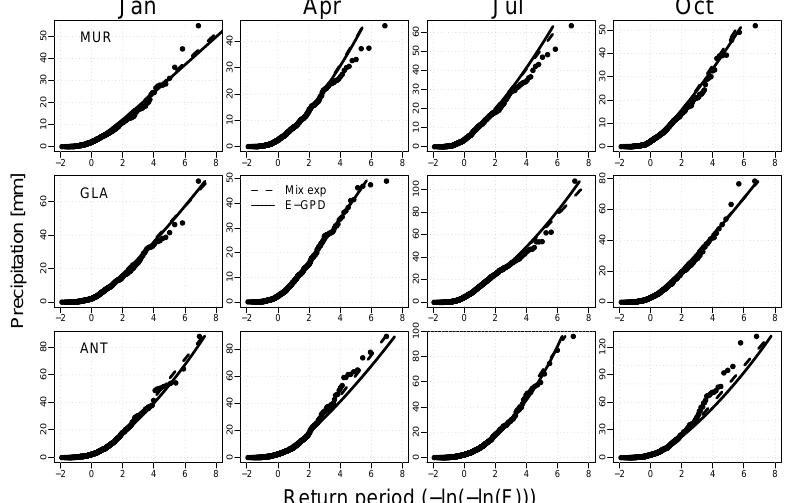
Figure 6. Empirical and fitted distributions (dashed curves for mixture of exponentials and solid curves for E-GPD) at a daily scale, for the three illustrative stations and for the months of January, April, July, and October.